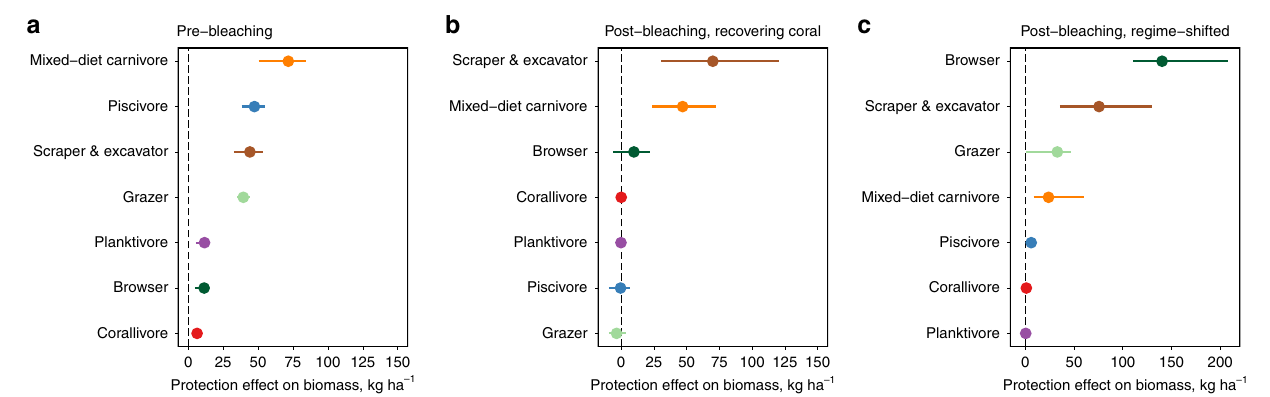
Fig. 4 Marine reserve effects on fi sh functional groups pre- and post- bleaching. Points are the mean difference in biomass between protected and fi shed areas, with drop-one jackknife error bars representing the uncertainty in reserve effects attributable to individual reef sites. a Higher fi sh biomass in marine reserves pre-bleaching was primarily driven by mixed-diet carnivores, and piscivores, with smaller contributions from scrapers & excavators and grazers. All groups had higher biomass in the 9 reserves compared to 12 fi shed reefs. b On the 12 reefs that recovered coral cover following major bleaching, higher biomass in reserves compared to fi shed areas was now dominated by scraper and excavator fi sh, followed by mixed-diet carnivores. Several functional groups show no reserve effect. c On the nine reefs that underwent regime shifts to macroalgae, the greatest biomass difference between fi shed and protected reefs was for macroalgal browsing fi sh, followed by scraper & excavator and grazer groups. Source data are provided as a Source Data fi